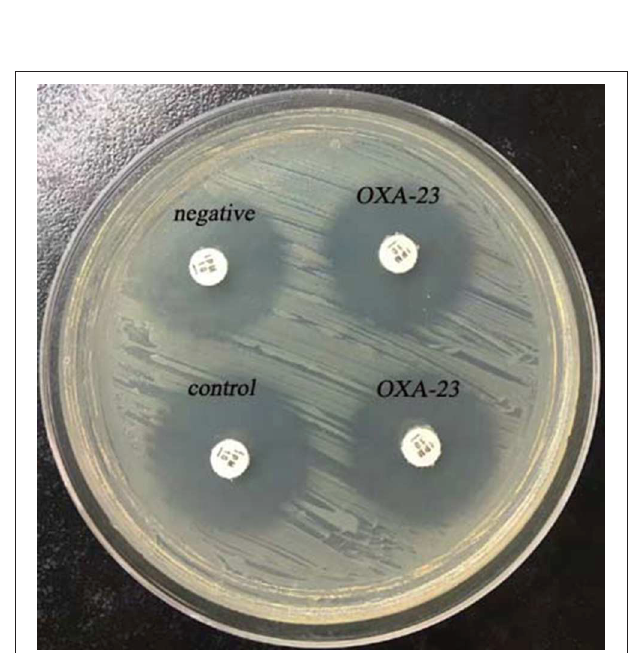
FIGURE 3 | Results of rCDM testing of A. baumannii (6h). The zone of inhibition of the control was 23mm, and the zones of inhibition of the OXA-23-producing A. baumannii were